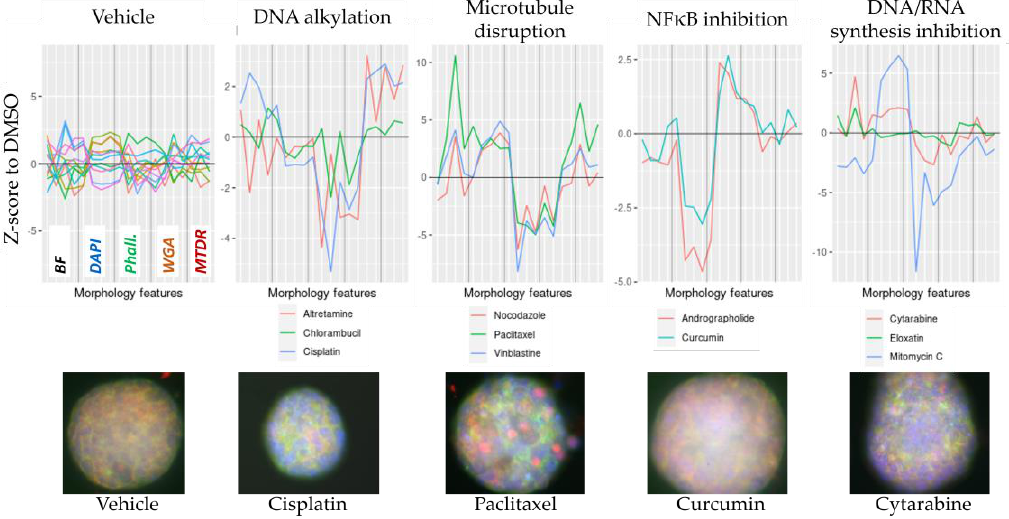
Figure 7. Compound phenotypic profiles using four selected intensity-based features (Median Nuclei Intensity, Median Nuclei Fraction at Distance 2, Median Nuclei Texture, and Standard Deviation of Nuclei Intensity) across all five channels (Brightfield, DAPI, Rhodamine Phalloidin, Alexa Fluor 594 WGA, and MTDR dye indicated by grey vertical lines). Example composite images (20×, one z-slice, CellInsight CX7 LZR platform) of compounds corresponding to the profiles above.